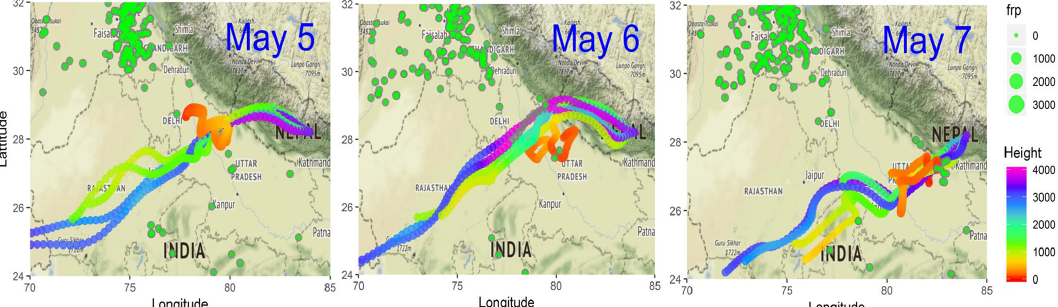
Figure 6. HYSPLIT (Hybrid Single Particle Lagrangian Integrated Trajectory, Draxler and Hess, 1998) 3-day back trajectories of air masses arriving at three different heights (800, 1500, and 2500m) from above the ground level (a.g.l. ∼ 815ma.s.l.) in the Pokhara Valley (28.19 ◦ N, 83.98 ◦ E) during 5–7 May 2016. NCEP GDAS (Global Data Assimilation System) Reanalysis data with 1 ◦ × 1 ◦ horizontal resolution were used as the input meteorology. The trajectory data are overlayed with the active fire data (extracted from the MODIS collection 6 database, available at https://firms2.modaps.eosdis.nasa.gov/active_fire/ (last access: 10 October 2018). Each green dot with a gray edge is an active fire, and the strength of the active fire is indicated by the “ frp ” value , which is the fire radiative power in